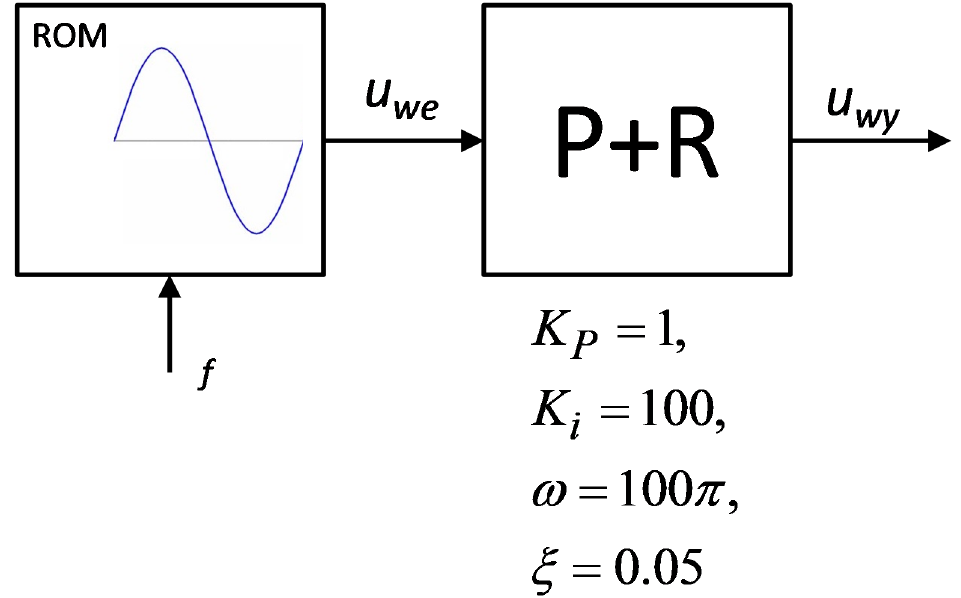
Figure 3. Schematic diagram of a system to determine Bode plot. Tests of amplitude–frequency characteristics were performed for the input signal frequency range from 40 to 60 Hz, while the regulator resonance frequency was 50 Hz. The results of these tests are shown in Figure 4.